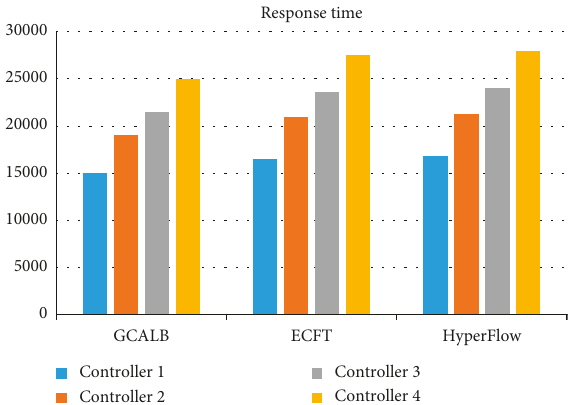
Figure 19: Average response time for GCALB, ECFT, and HyperFlow among four controllers.